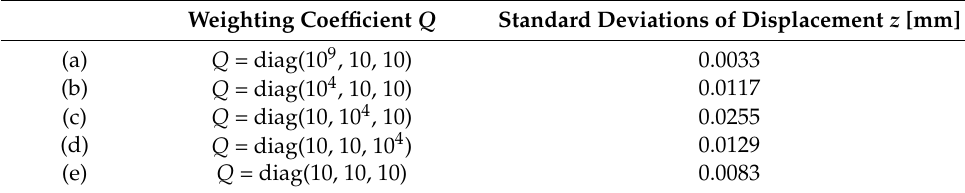
Figure 7. Time histories of the vertical displacement of the steel plate. Table 3. Standard deviations of displacement of each weighting coefficient pattern.